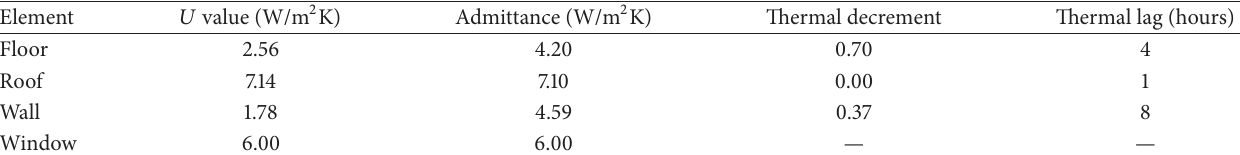
Figure 1: Experimental setup. (a) External sensors. (b) Automated data acquisition system. Table 1: Properties of the basic material elements used in the construction of the PSH.